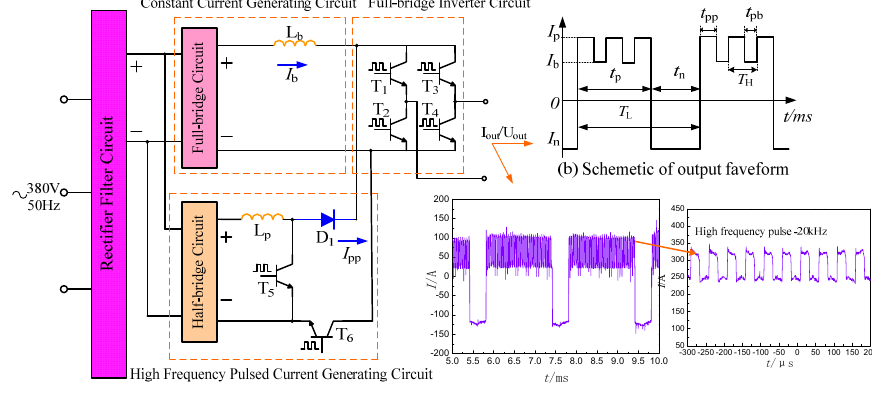
Figure 1. Schematic diagram of circuit topology and output waveform of hybrid ultrasonic frequency pulsed variable polarity gas tungsten arc wending (HPVP-GTAW). T L —period of variable polarity current; f L = 1/ T L —variable polarity frequency; I n —negative current; I b —high-frequency pulsed background current; I p —high-frequency pulsed peak current; T H —period of pulsed current; δ = t pp / T H —pulse duration; f H = 1/ T H —pulse